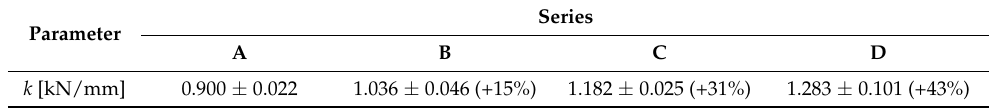
Table 9. Average values of stiffness coefficient k